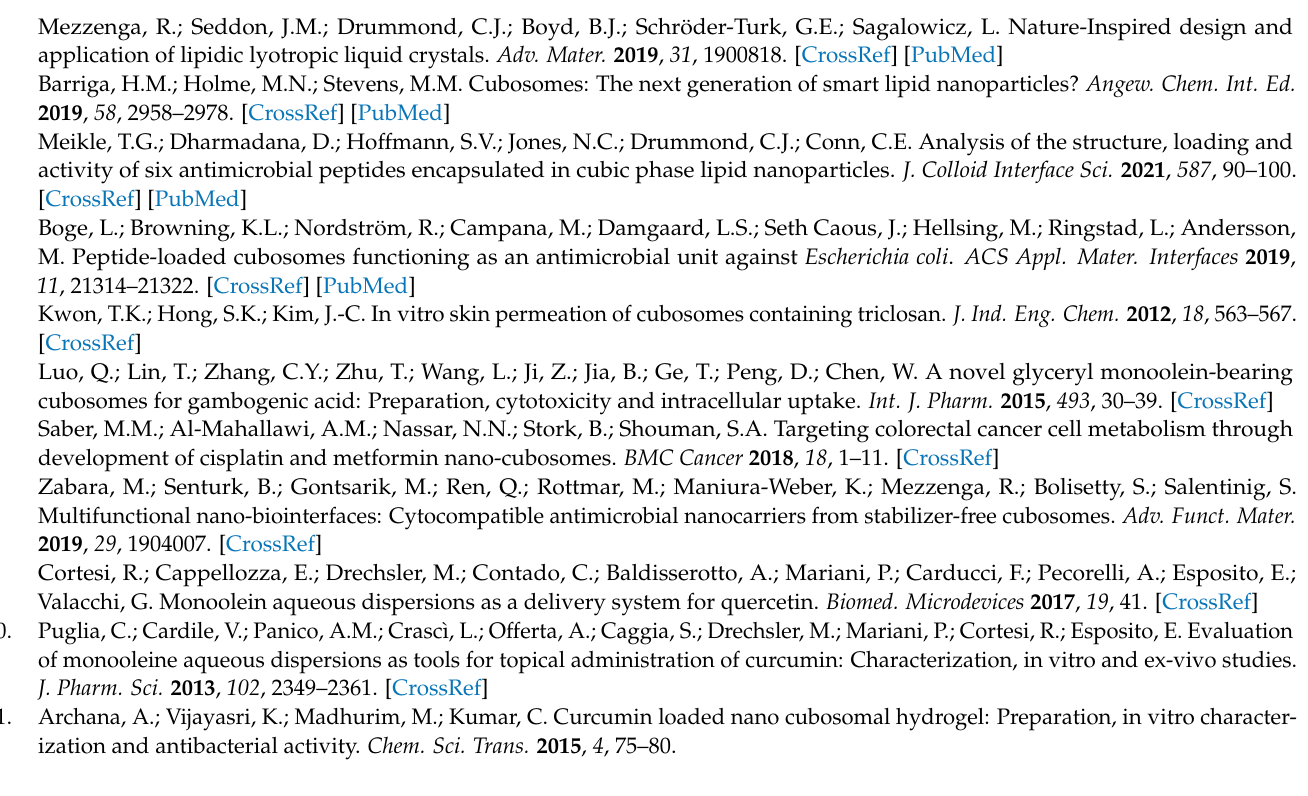
), Figure S2: Concentration of (cid:32)